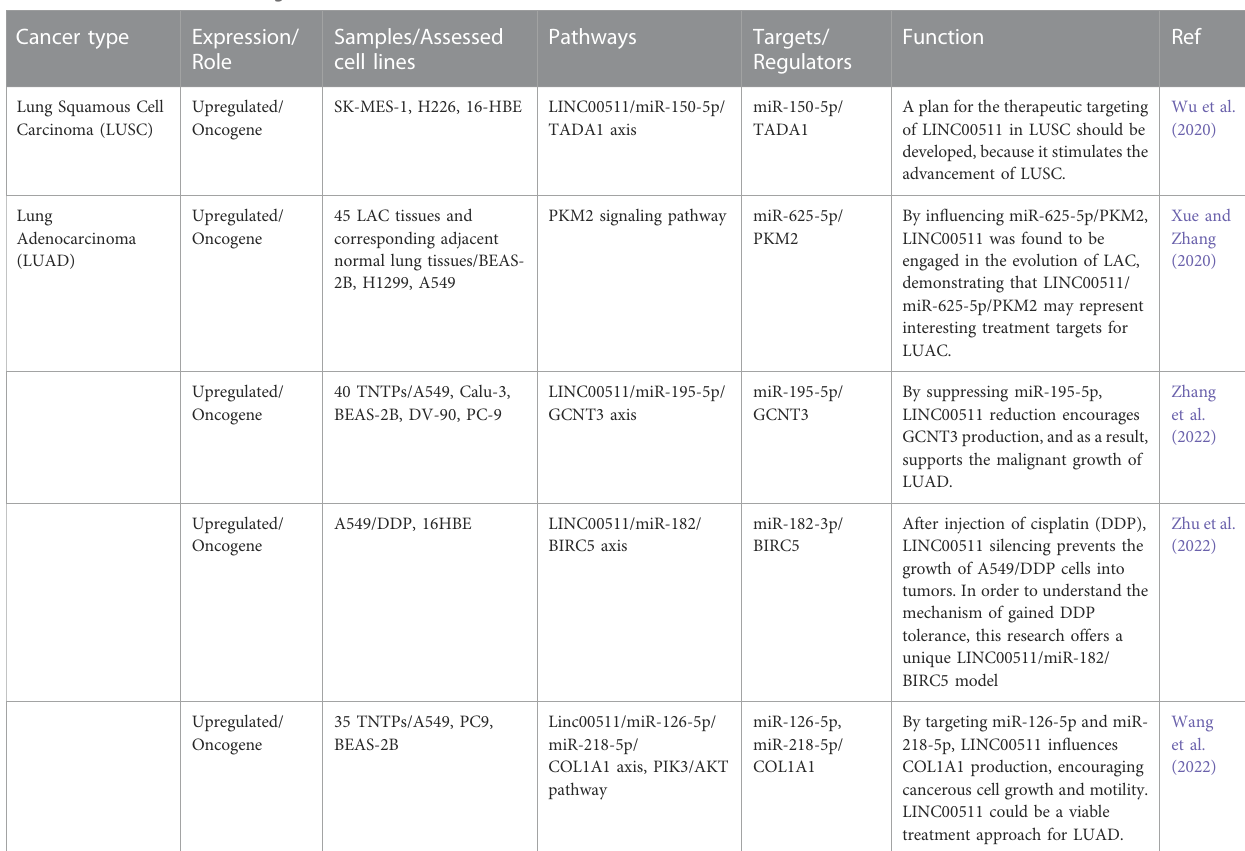
TABLE 3 Role of LINC00511 in lung